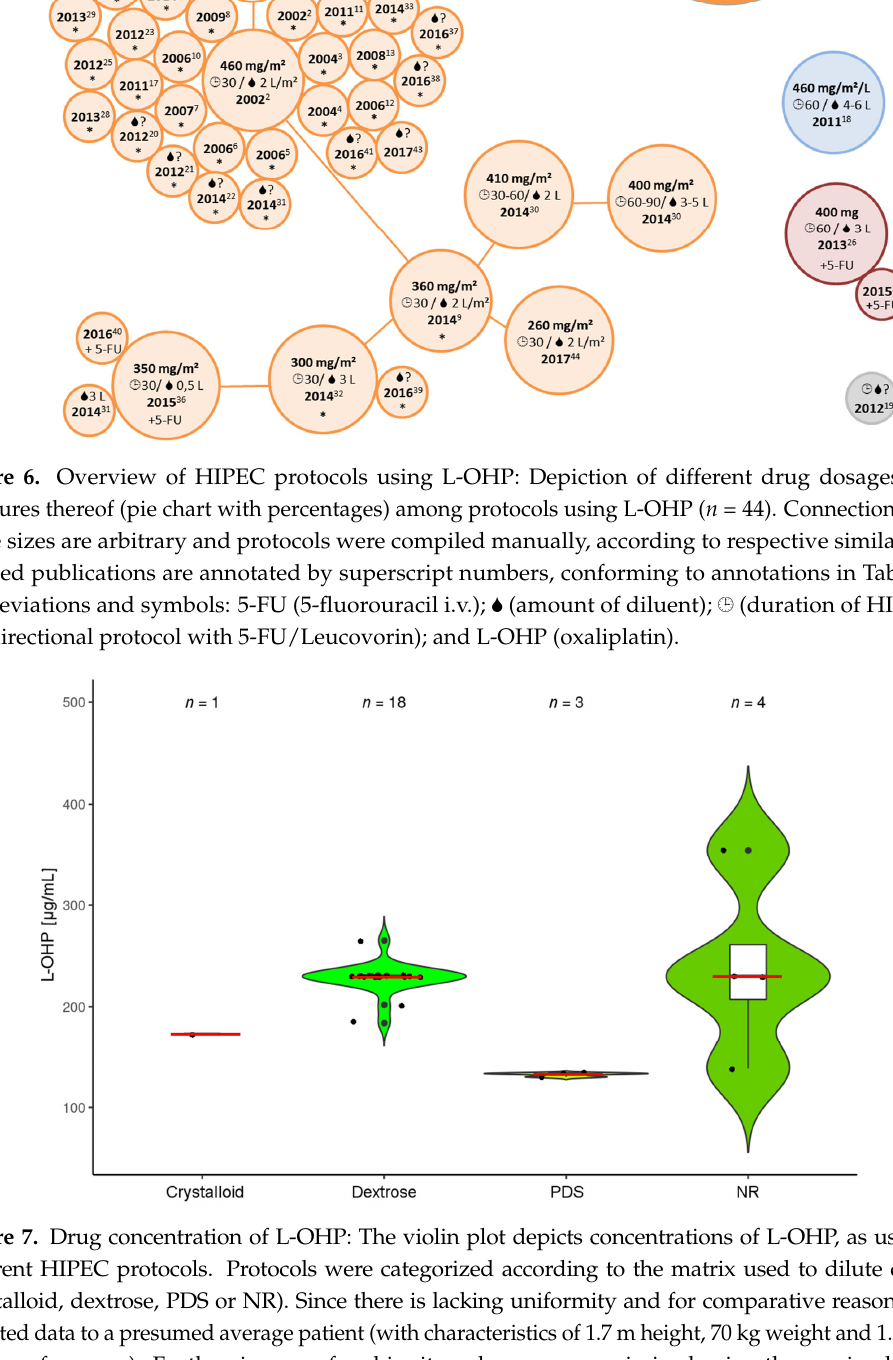
Figure 5. Drug concentration of MMC: The violin plot depicts concentrations of MMC as used in different HIPEC protocols. Protocols were categorized according to the matrix used to dilute drugs (crystalloid, dextrose, PDS or NR). Since there is lacking uniformity and for comparative reasons, we imputed data to a presumed average patient (with characteristics of 1.7 m height, 70 kg weight and 1.73 m 2 body surface area). Further in the case of ambiguity values were maximized using the maximal drug amounts and the minimum diluent volumes reported. The red bars mark medians and white boxes interquartile range. Protocols with missing data or reporting ≤4 patients were omitted. (Median drug concentrations (µg/mL): crystalloid: 13.3; Dextrose: 7.2; PDS: 10.8; NR: 10). Abbreviations used: MMC (mitomycin c); PDS (peritoneal dialysis solution); and NR (not reported). 3.5. HIPEC Conduct with Oxaliplatin (L-OHP) The second most frequently used HIPEC drug was L-OHP, which was used according to 26% of reports (Figure 2c) [28,31–35,54,55,60,65,66,69,72,75,76,81–83,91,108,111,116,121,127–150]. With L- OHP a remarkable homogeneity concerning drug dosing was observed and all but four articles used